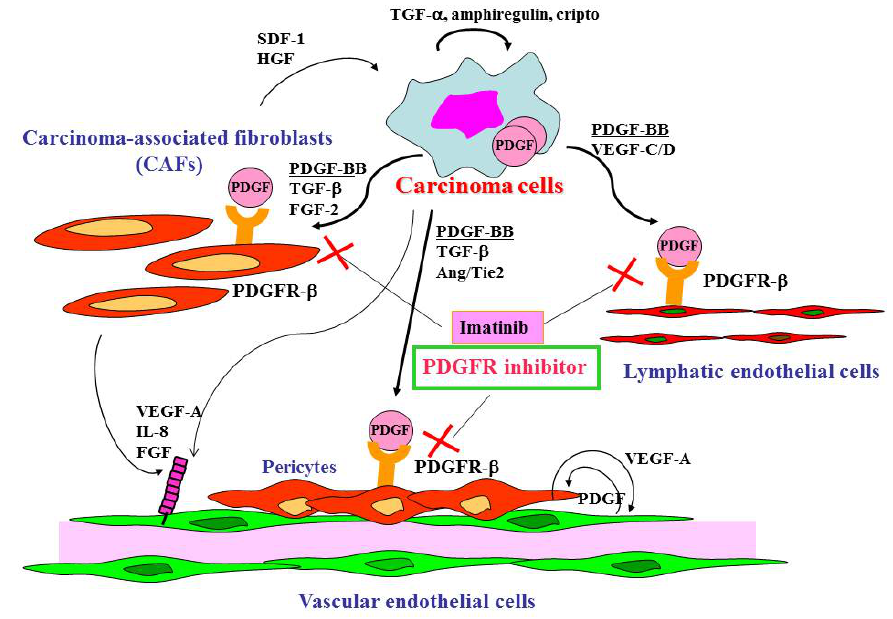
Figure 1. Gastric cancer cells express a variety of growth factors and cytokines, which act in an autocrine or paracrine manner. Interaction between tumor cells and stromal cells through the PDGF/PDGF receptor (PDGFR) system influences stromal reaction, lymphangiogenesis and maturation of tumor vessels. PDGFR tyrosine kinase inhibitor can modulate the tumor microenvironment and enhance the effect of chemotherapeutic